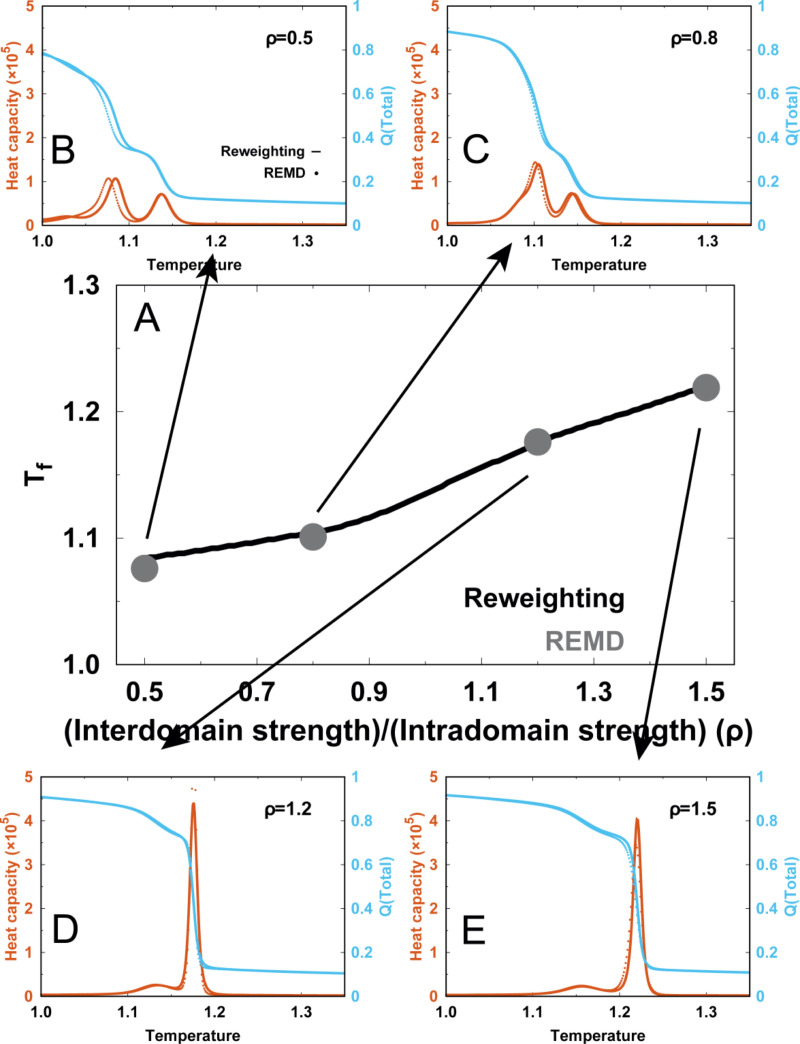
Comparisons of the thermodynamics between the reweighing method (solid lines) and direct REMD simulations (dots).(A) Comparisons of folding temperatures. The REMD simulations with directly applying four different ρ, which are (B) ρ=0.5, (C) ρ=0.8, (D) ρ=1.2 and (E) ρ=1.5, were performed and analyzed. In (B-E), comparisons of heat capacity curves (blue) and melting curves of Q⁢(Total) (red) with these four different ρ are shown.